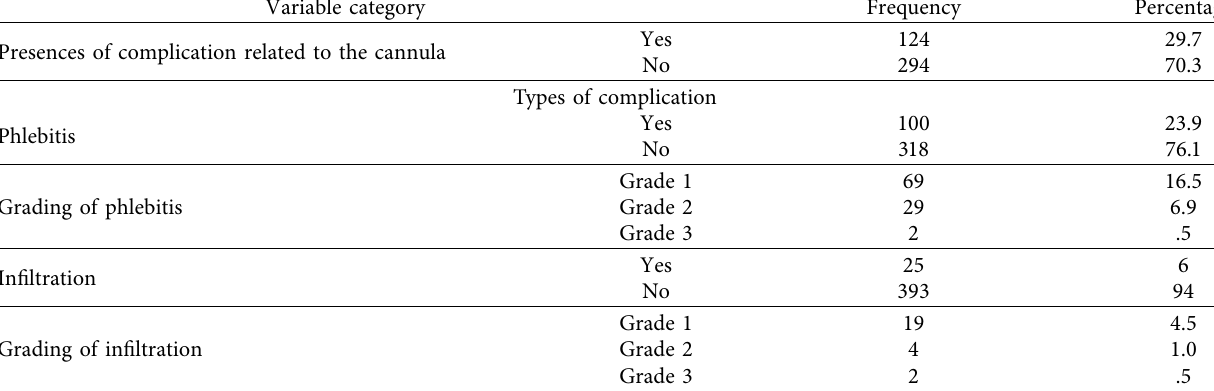
Table 3: The incidence and severity of peripheral cannula-related complications to assess the incidence and associated factors of failed first intravenous catheter among adult inpatients at medical-surgical wards in Public Referral Hospitals of West Amhara Regional State, Ethiopia, 2021 ( N �